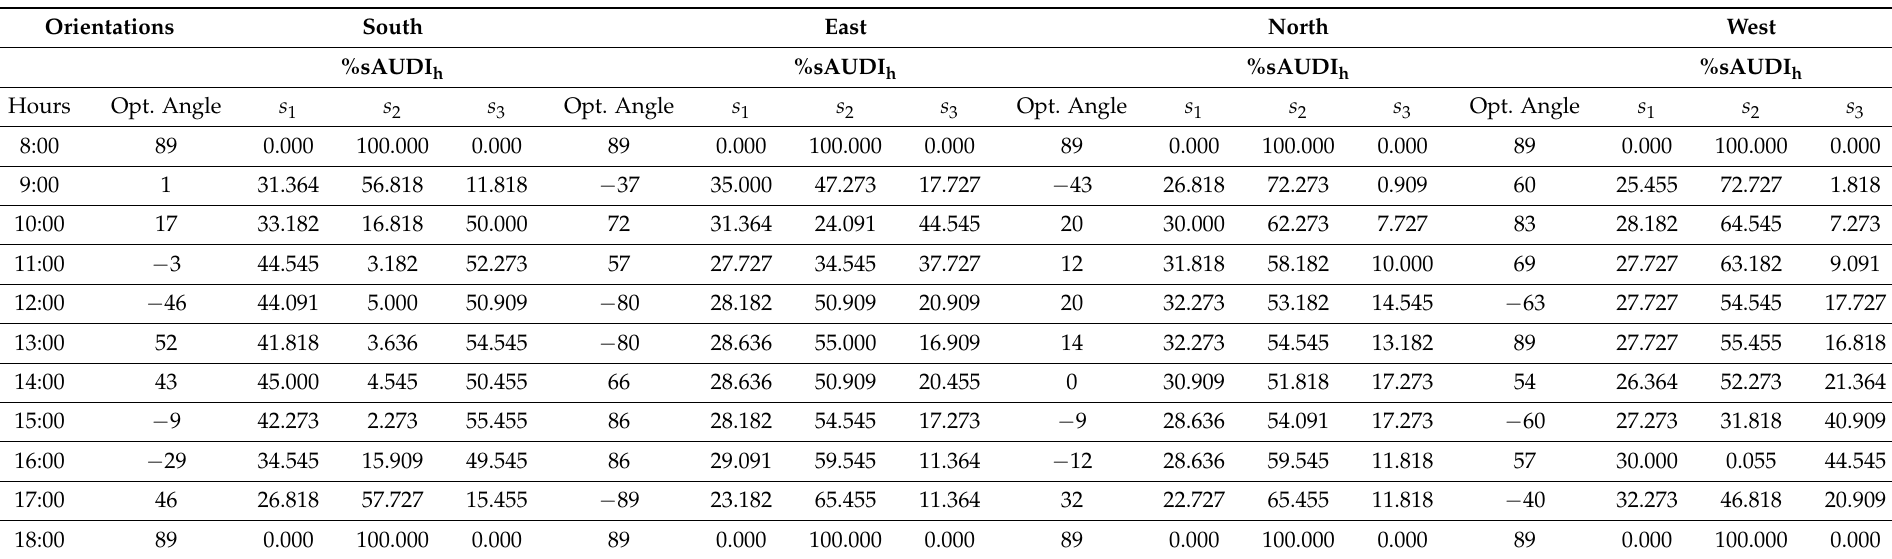
Table 5. Hourly optimum angles and the associated sAUDI h for three different human activities of s 1 , s 2 , and s 3 and four facade orientations calculated for 21 December-Phoenix-Vertical